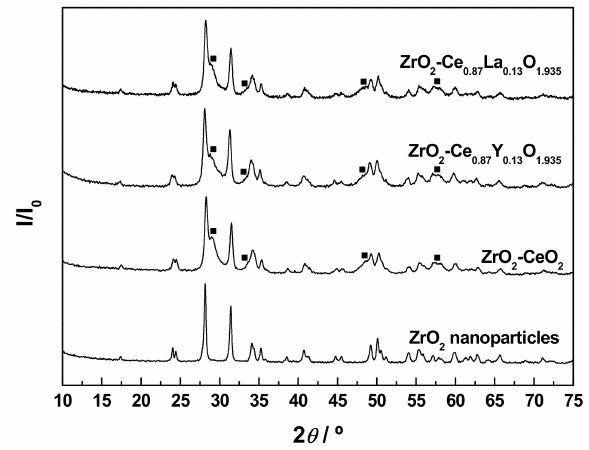
Figure 7. XRD patterns recorded for the undoped and Ln-doped ZrO 2 -CeO 2 samples subjected to a reduction treatment in H 2 (5%) / Ar at 900 ◦ C for 1 h. Caption: (cid:4) Ce x Zr 1 − x O 2 − δ